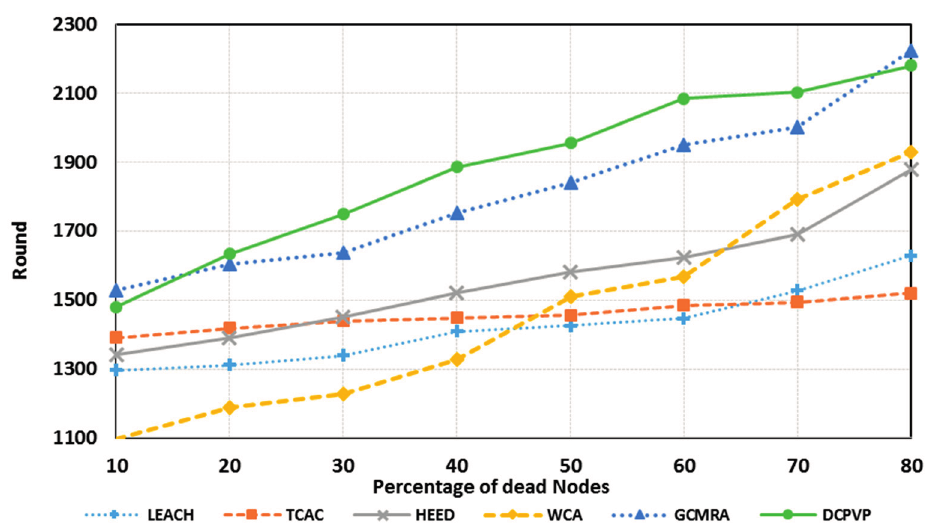
Figure 14. The percentage of dead nodes in random distribution for 100 nodes.